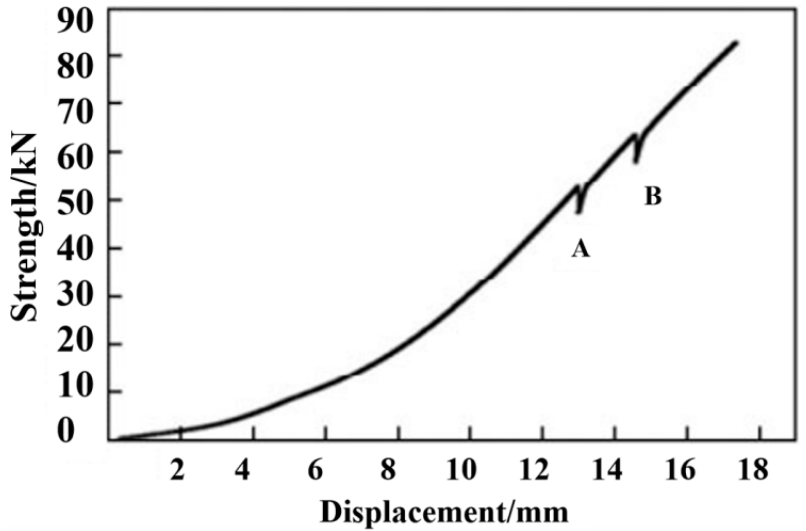
Figure 7. Load–displacement curve of axial tension.